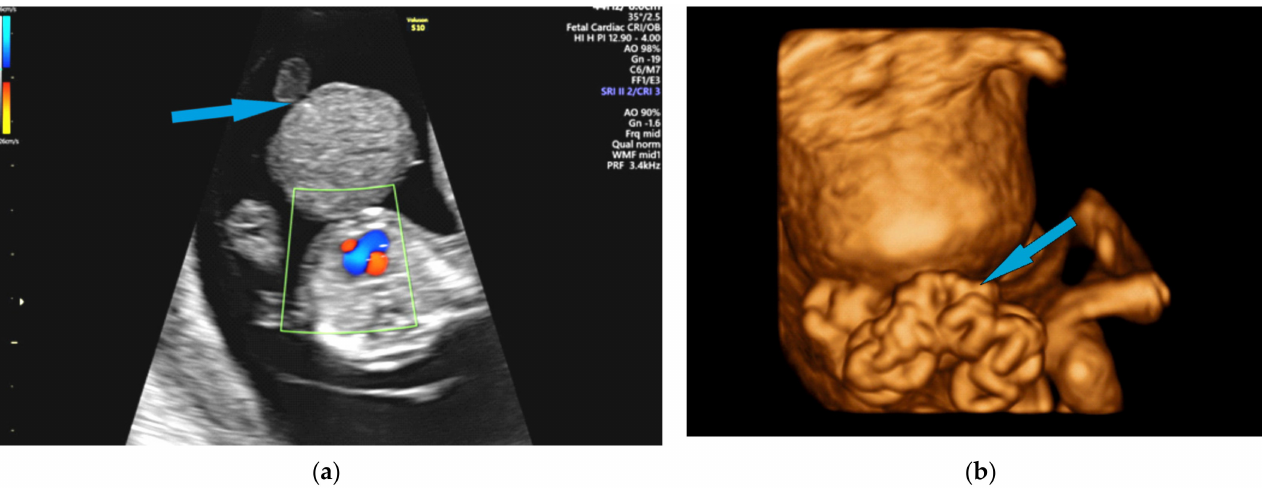
Figure 4. ( a ) Omphalocele and ( b ) gastroschizis ultrasound images of the 13 + gestational week–old fetuses on 2D color Doppler and 3D reconstruction, respectively; the blue arrow indicates fetal umbilical cord